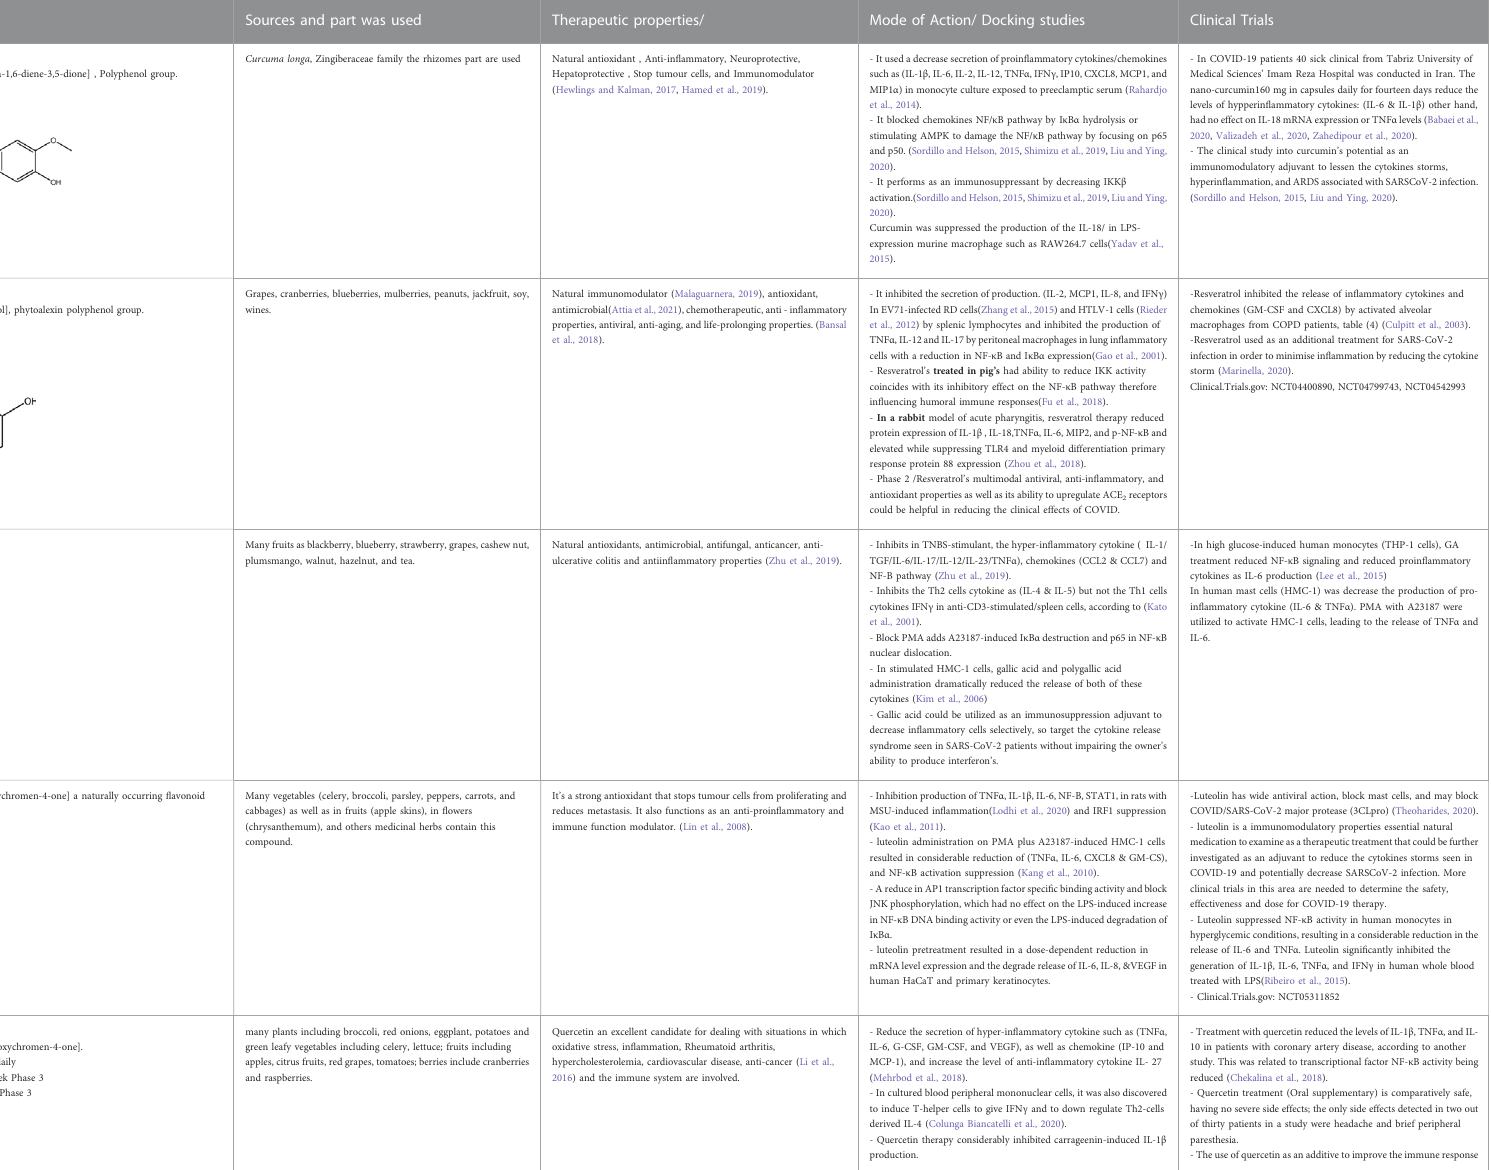
TABLE 3 Chemical structure of Natural compound list as Immunosuppressants as Adjuvants in managing COVID-19 to Target the Cytokine Storm. The remainder of this table can be found in the Supplementary Materisl. Natural metabolites,